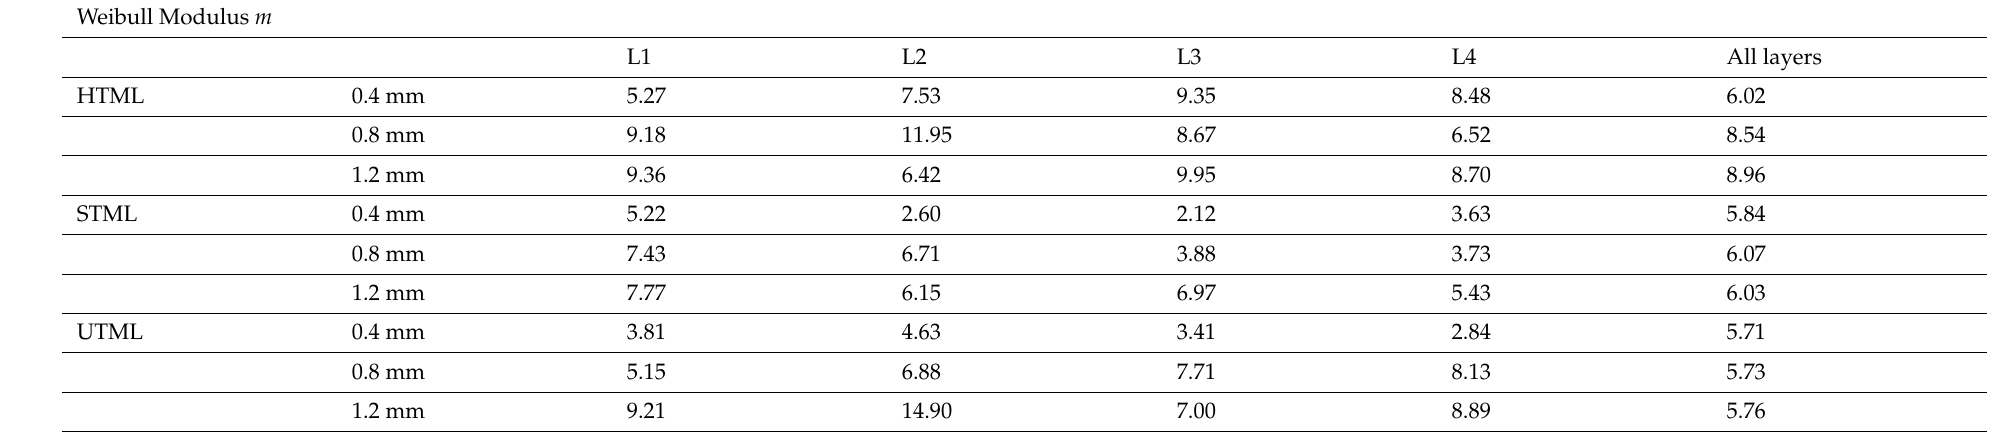
Table 3. Descriptive non-parametric statistics (mean ± SD) for Weibull modulus m and characteristic strength σ w for all tested